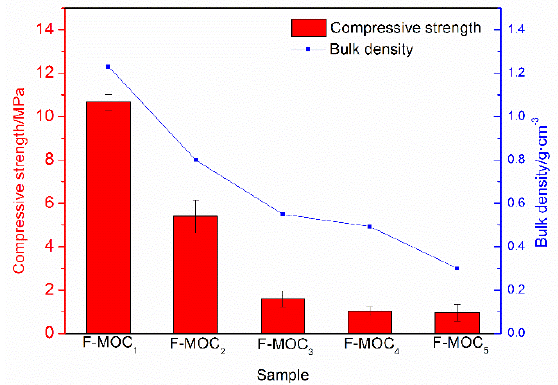
Figure 5. The compressive strength and the bulk density of F-MOC.